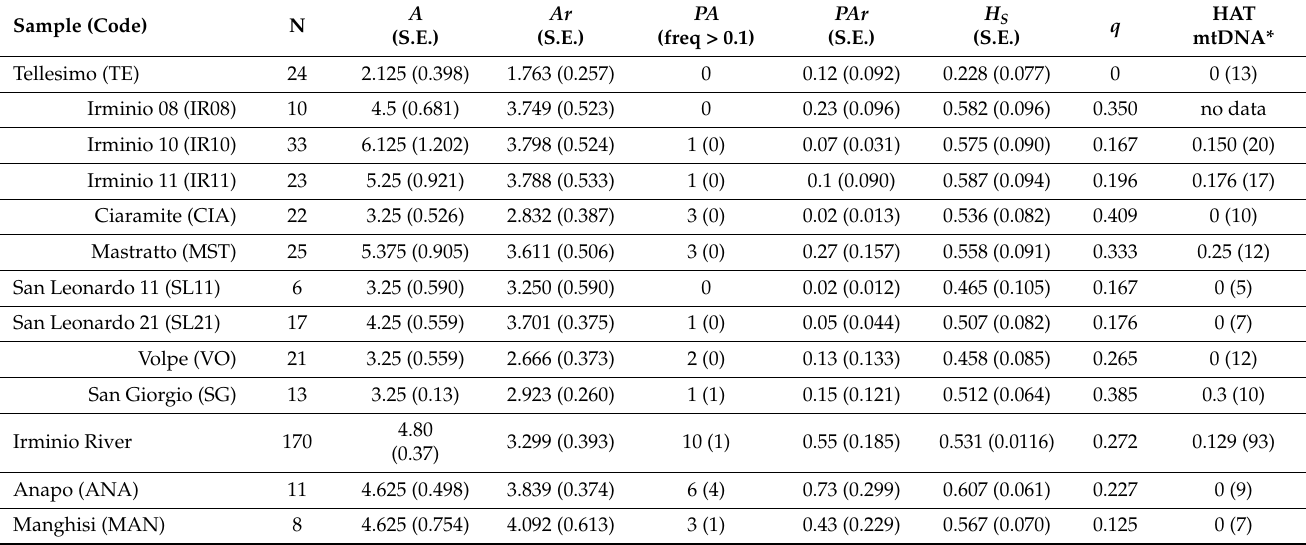
Table 1. Sample collections, geographic and genetic